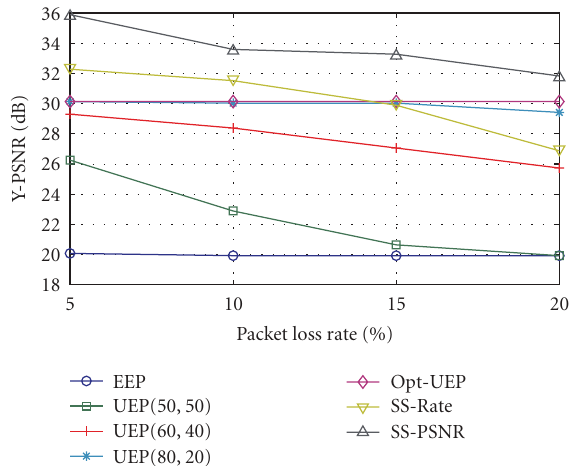
Figure 4: PSNR versus PLR at overall data rate of 1.1 Mbps for the “Paris” sequence—burst loss.